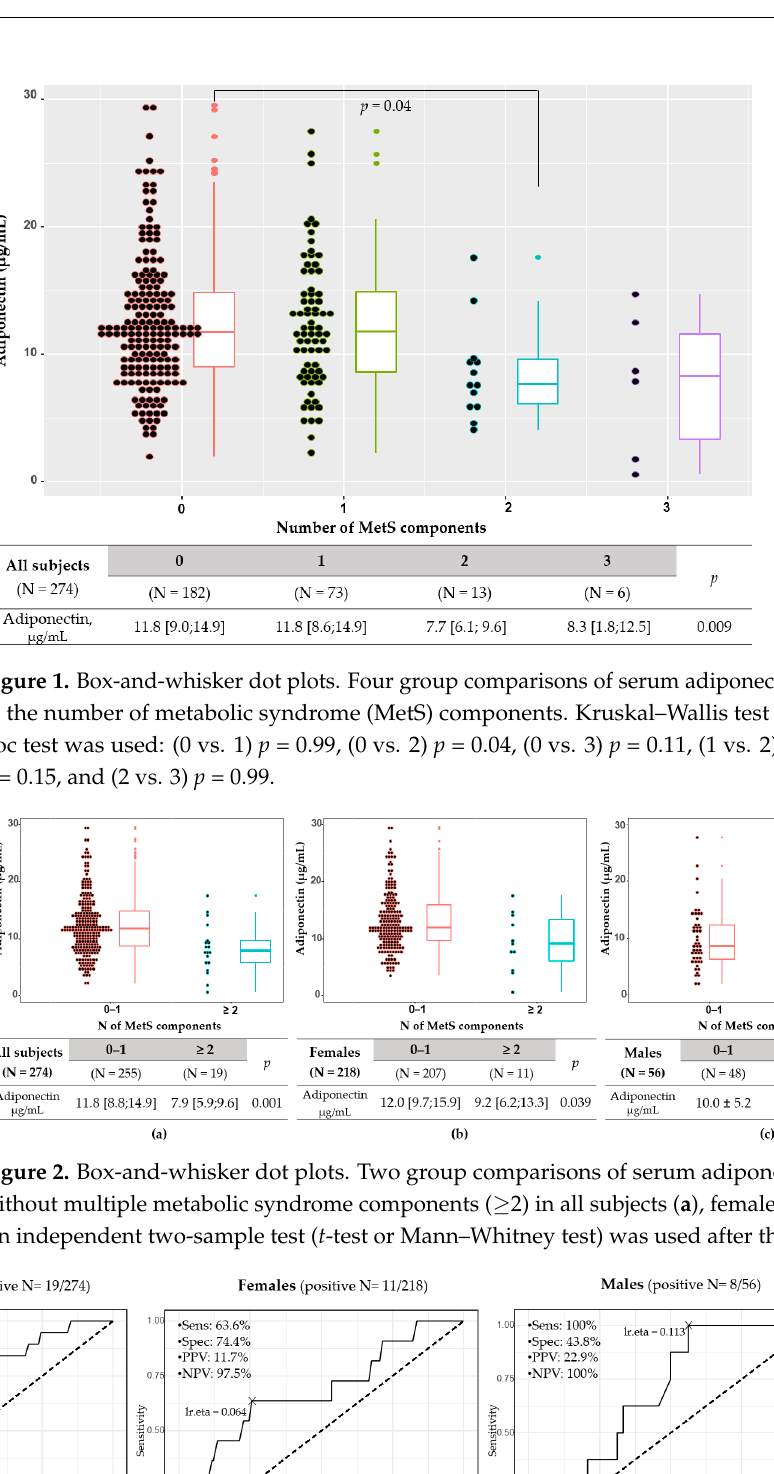
Figure 3. The receiver operating characteristic curves for serum adiponectin levels to predict multi- metabolic syndrome components (( a ): All subjects, ( b ): Females, and ( c ): Males). The area under the curve (AUC) with a 95% confidence interval is shown in each group. The optimal cutoff value by the Youden index is presented with sensitivity (Sens), specificity (Spec), positive predictive value (PPV), and negative predictive value (NPV).